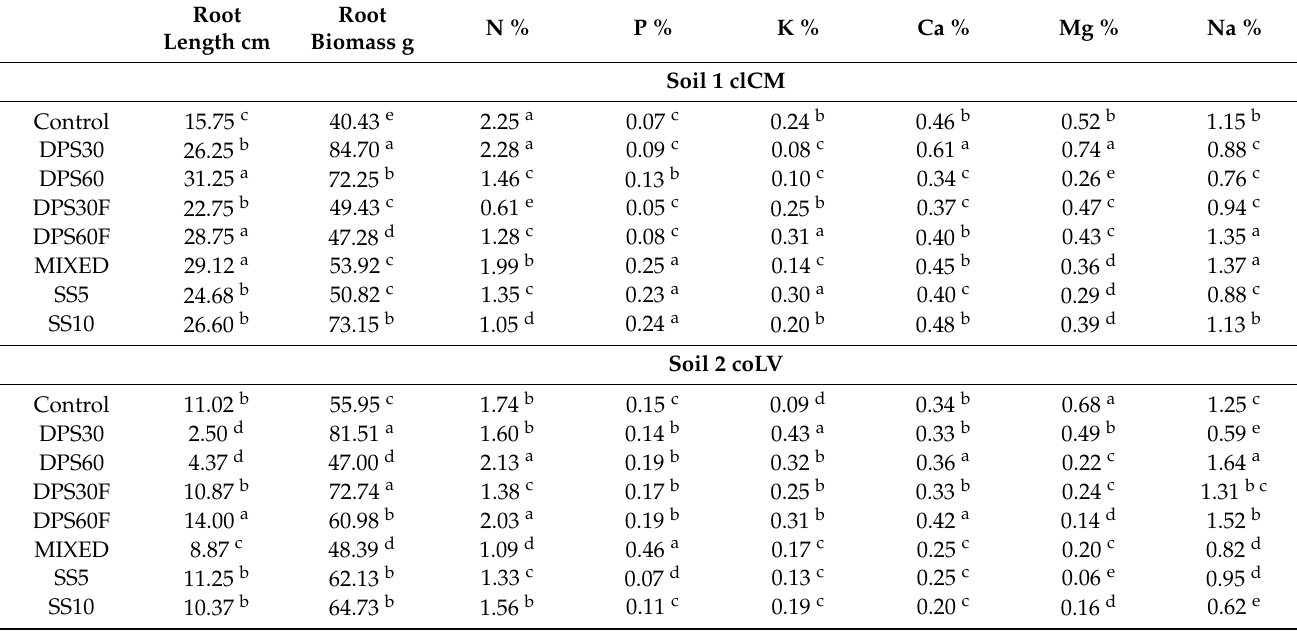
Table 8. Wheat root length and selected elemental composition affected by deinking paper sludge